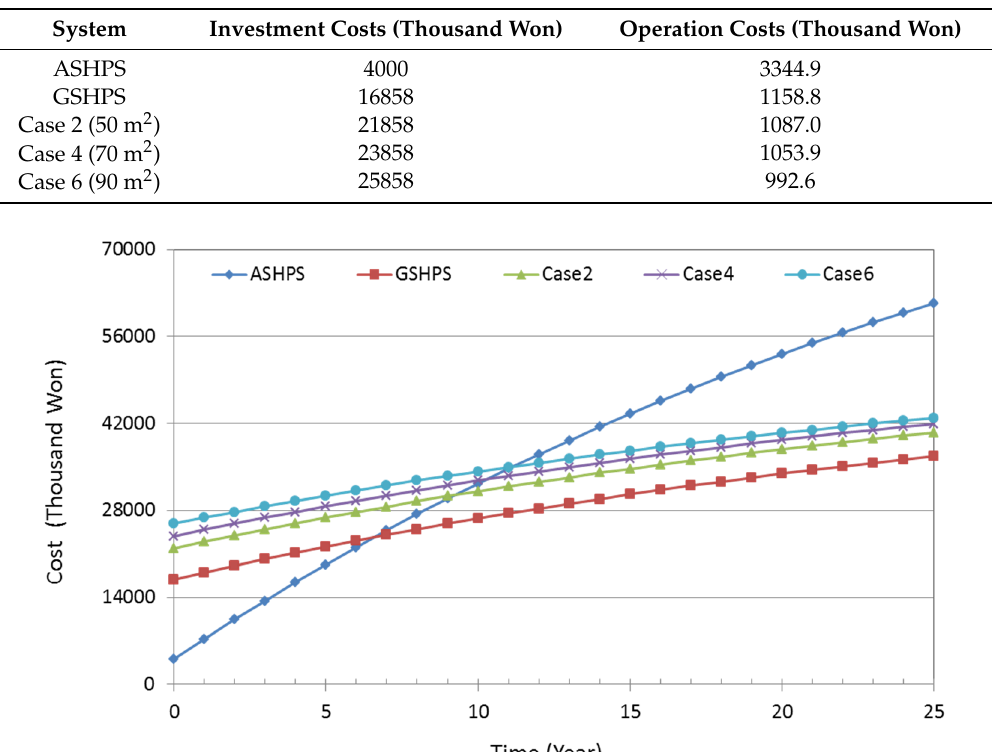
Table 4. The calculation results of investment costs and operation costs.